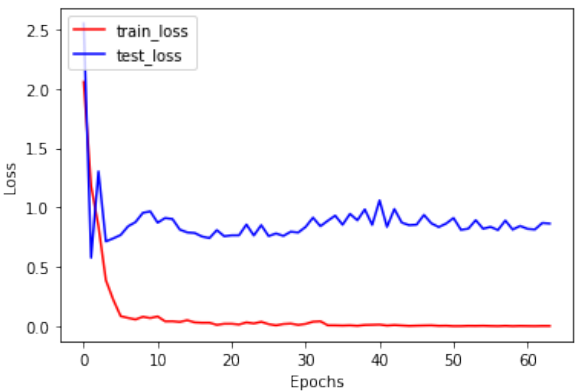
Figure 6. Loss curve for training and testing datasets.